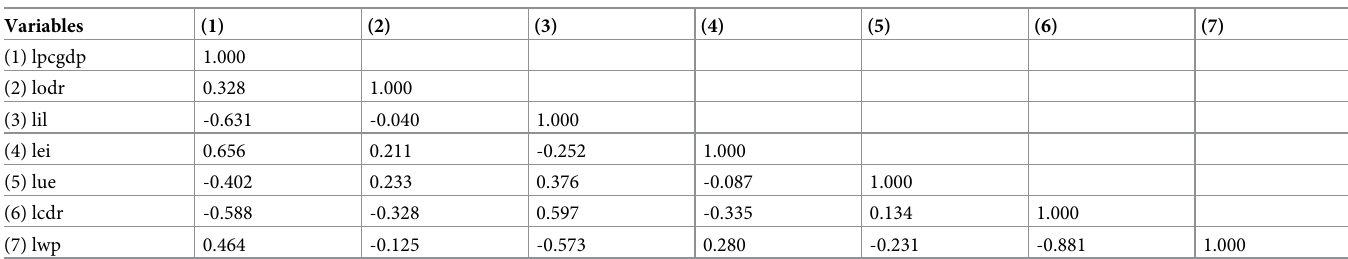
Table 6. Pairwise correlation of eastern region of China. Variables